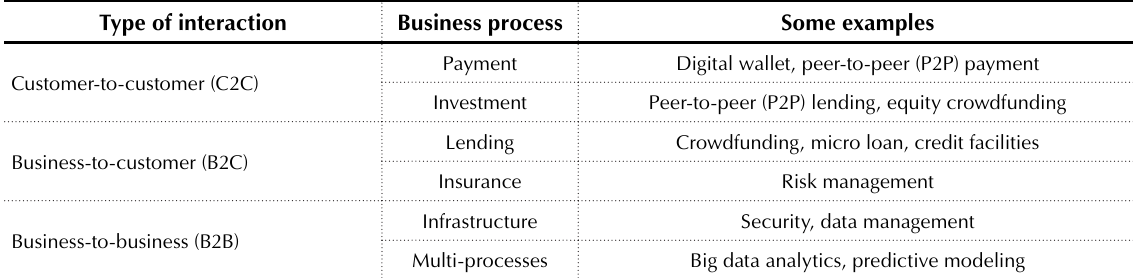
Type of interaction Business